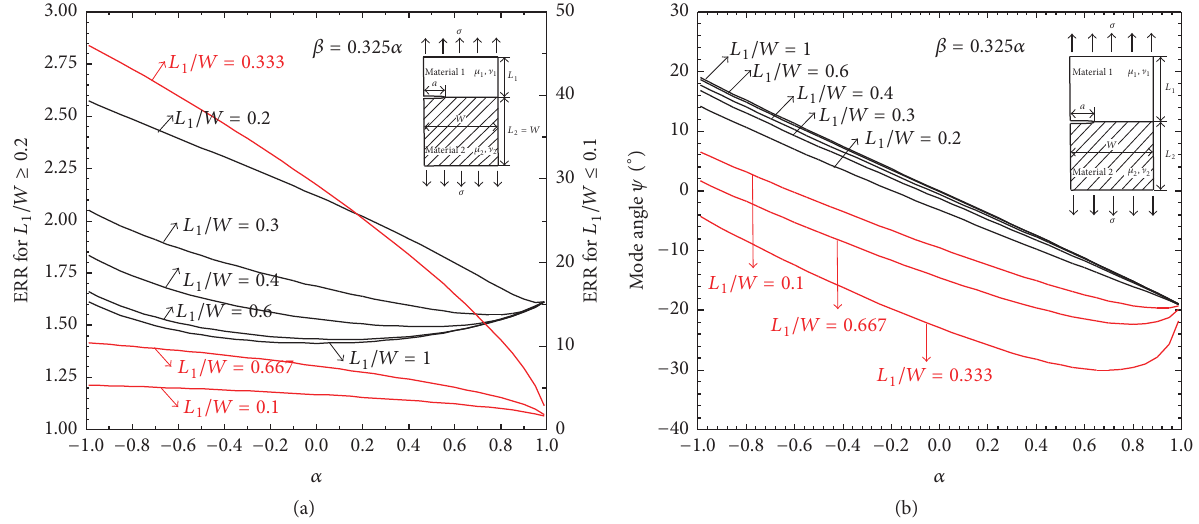
Figure 11: Variations of (a) normalized ERR 𝐺𝐸 ∗ /(𝜎 2 𝜋𝑎) and (b) mode angle 𝜓 of an asymmetrically bonded strip under 𝛽 = 0.325𝛼 .